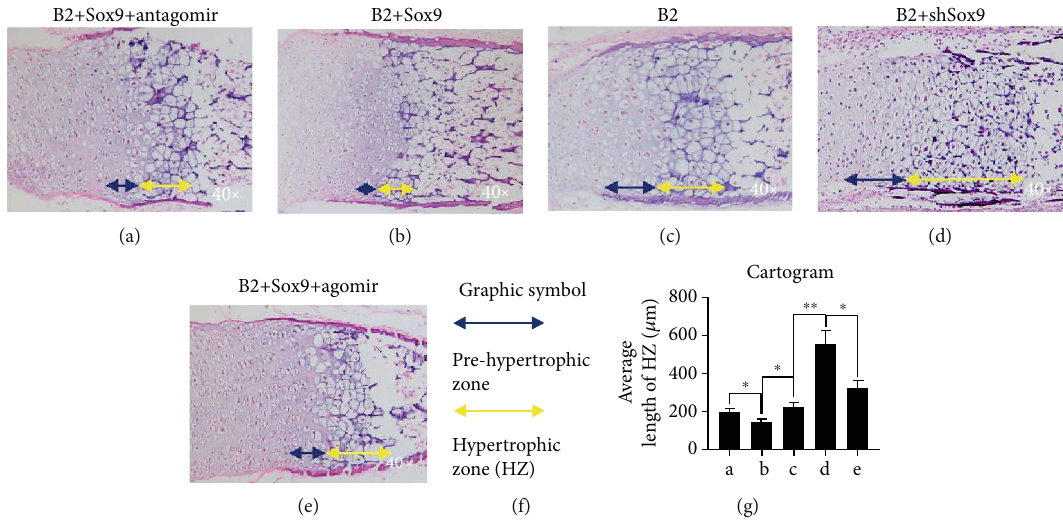
Figure 5: BMP2-induced chondrocyte hypertrophy in fetal mouse forelimb explant was inhibited by miR-322-5p. (a – e) Forelimbs were subjected to H&E staining for histological evaluation. (f) The arrows in dark blue and yellow represent the length of prehypertrophic and hypertrophic zone (HZ), respectively. (g) ∗ p < 0 : 05 ; ∗∗ p < 0 : 01 . B2: